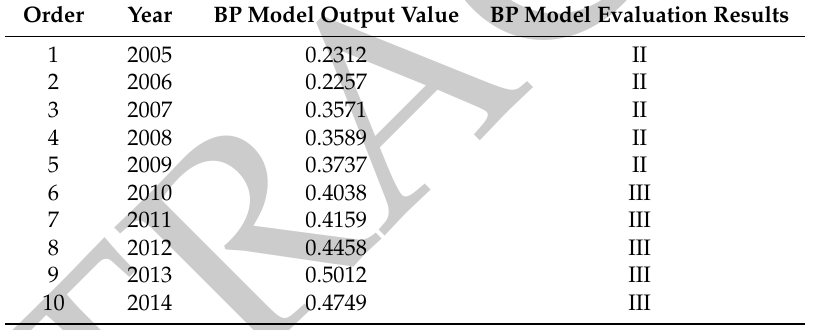
Table 5. Results of water resource security evaluation in the karst area based on the BP model.